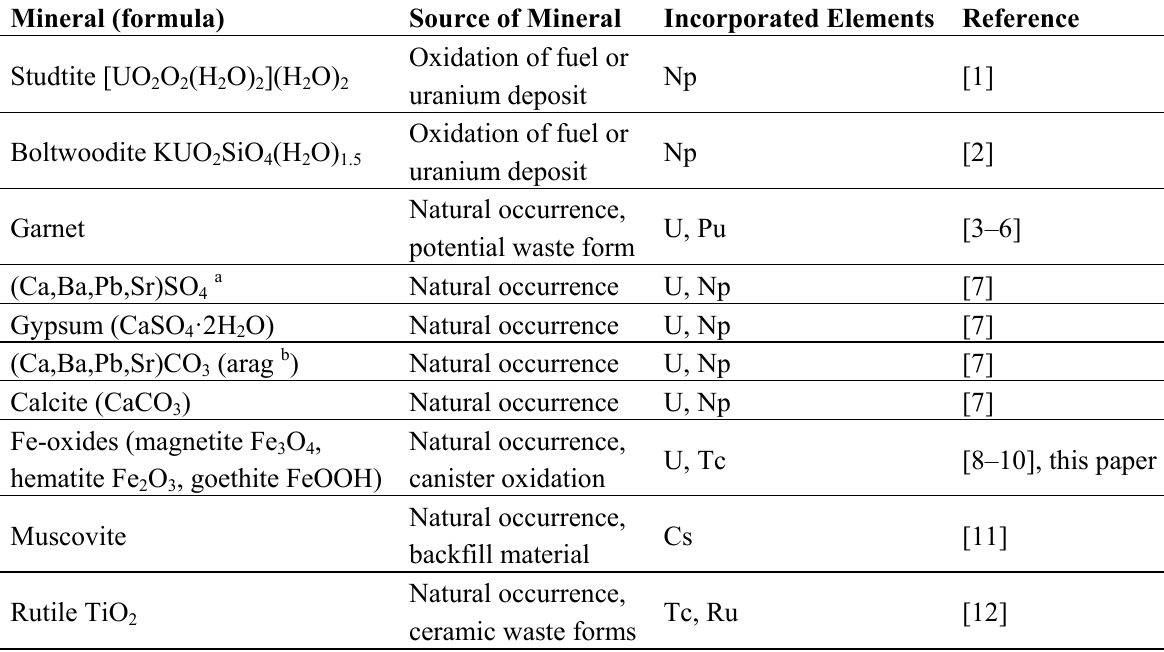
Table 1. Examples of incorporation reactions studied for better understanding of the transport of radionuclides in the